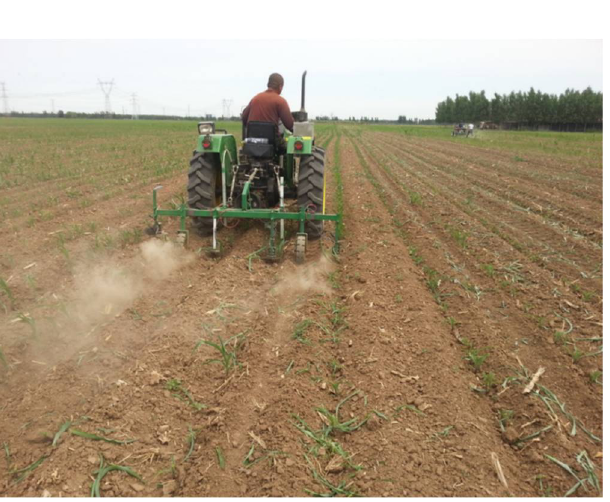
Figure 3. The practice of defoliation has been adopted by some farmers in maize production in northern China (courtesy of Mr Baojian Su).